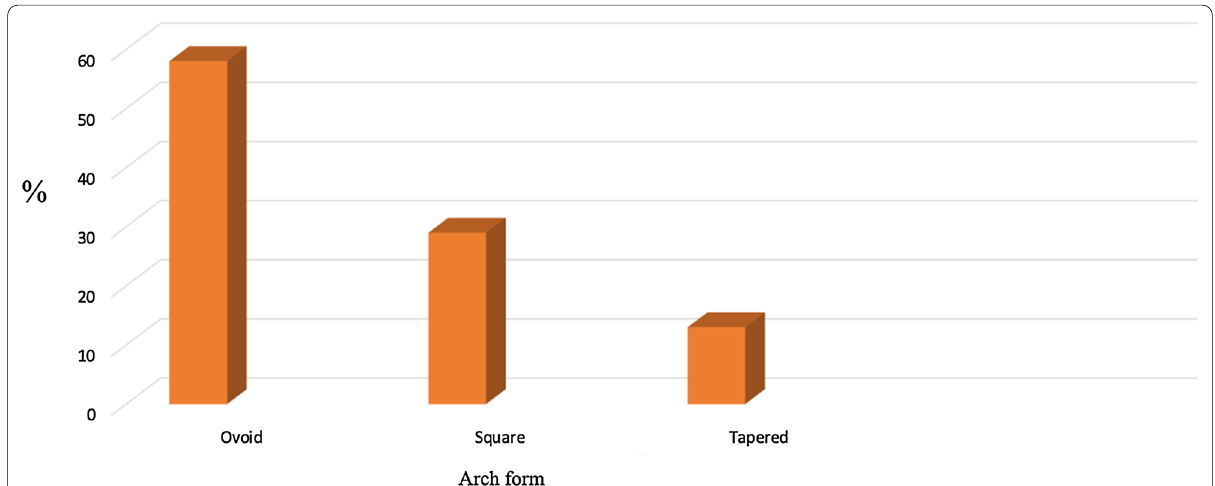
Fig. 2 Bar chart showing prevalence of ovoid, square and tapered arch forms among Egyptian children and